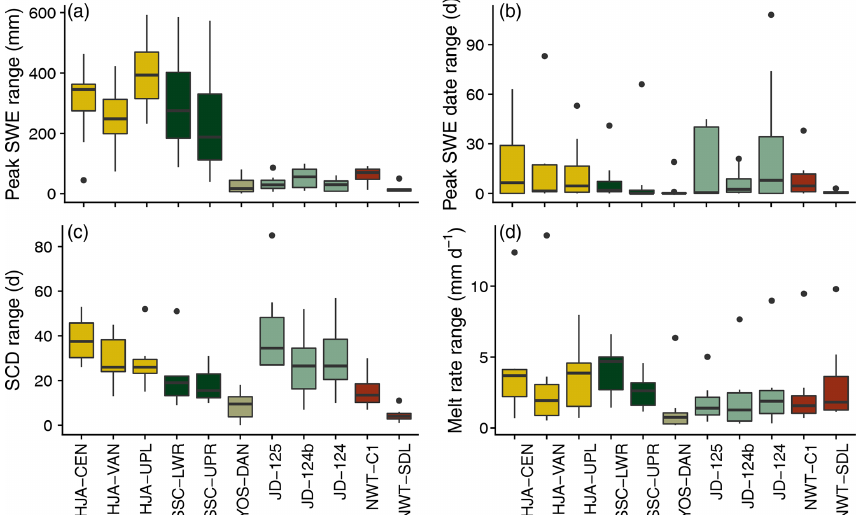
Figure 7. The annual range in simulated peak SWE (a) , peak SWE date (b) , snow cover duration (c) , and melt rate (d) due to precipitation phase method selection at the study